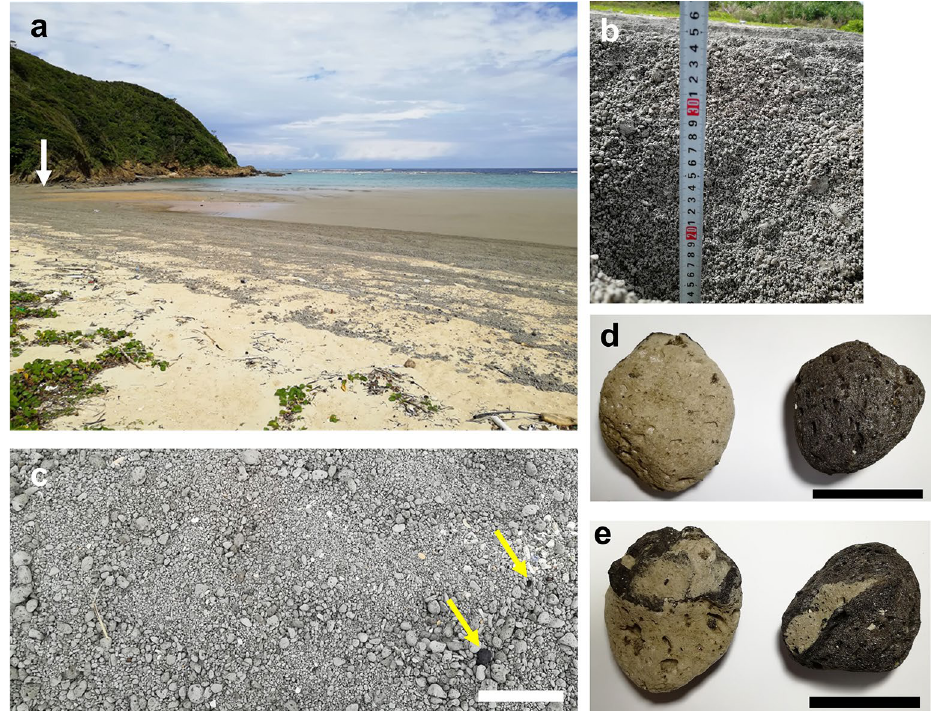
Figure 2. An example of a natural beach on Okinawa Island where pumice has washed ashore. ( a ) Appearance of natural sandy beaches on the northern part of Okinawa Island (Ibu beach, Kunigami Village, 26°75 ′ 57.88" N, 128°32 ′ 23.32" E). Photo was taken on 24 October 2021. Pumice drifted onto the sandy beach and formed a striped pattern. The white-capped waves indicate on the place where the reef edge exist. The white arrow points to the mangrove river estuary corresponding to Fig. 9. ( b ) Estimation of the pumice sedimentation depth on the original sand beach surface. ( c ) The high tide zone of the natural sandy beach is covered with pumice pebbles and stones. Yellow arrows indicate black pumice stones. Scale bar: 10 cm. ( d , e ) Front and back of examples of relatively large pumice stones from the same beach. The left image is mostly light brown, whereas the right image is almost black. Scale bars: 5